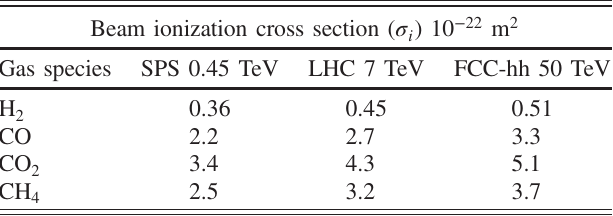
TABLE VI. Comparison of the ionization cross sections for the FCC-hh and previous proton accelerators, with a clear depend- ence on the beam energy [61].